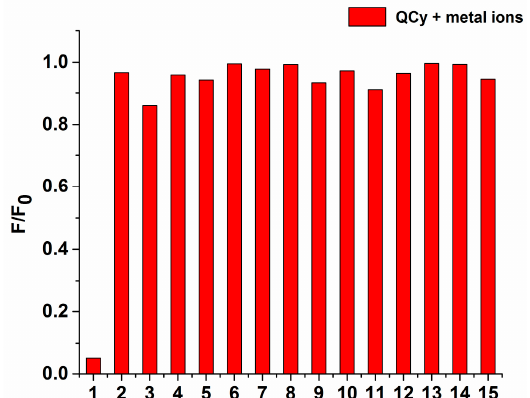
Figure 3. The chart showed an interference test of QCy in the presence of 7.0 μ M of different metal ions (Ag + , Fe 2+ , K + , Na + , Ca 2+ , Zn 2+ , Mg 2+ , Pb 2+ , Ni 2+ , Mn 2+ , Cd 2+ , Cu 2+ , Hg 2+ ). All studies were acquired in a mixed solvent of EtOH/PBS (1/9, v/v, pH = 7.0, 10